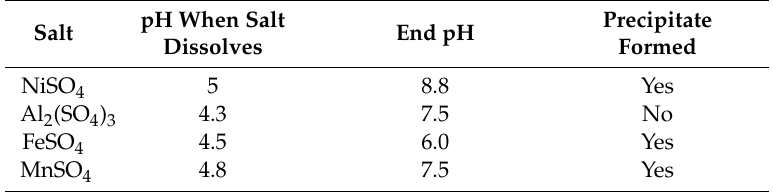
Table 4. Precipitation as hydroxides of some metals by simple pH